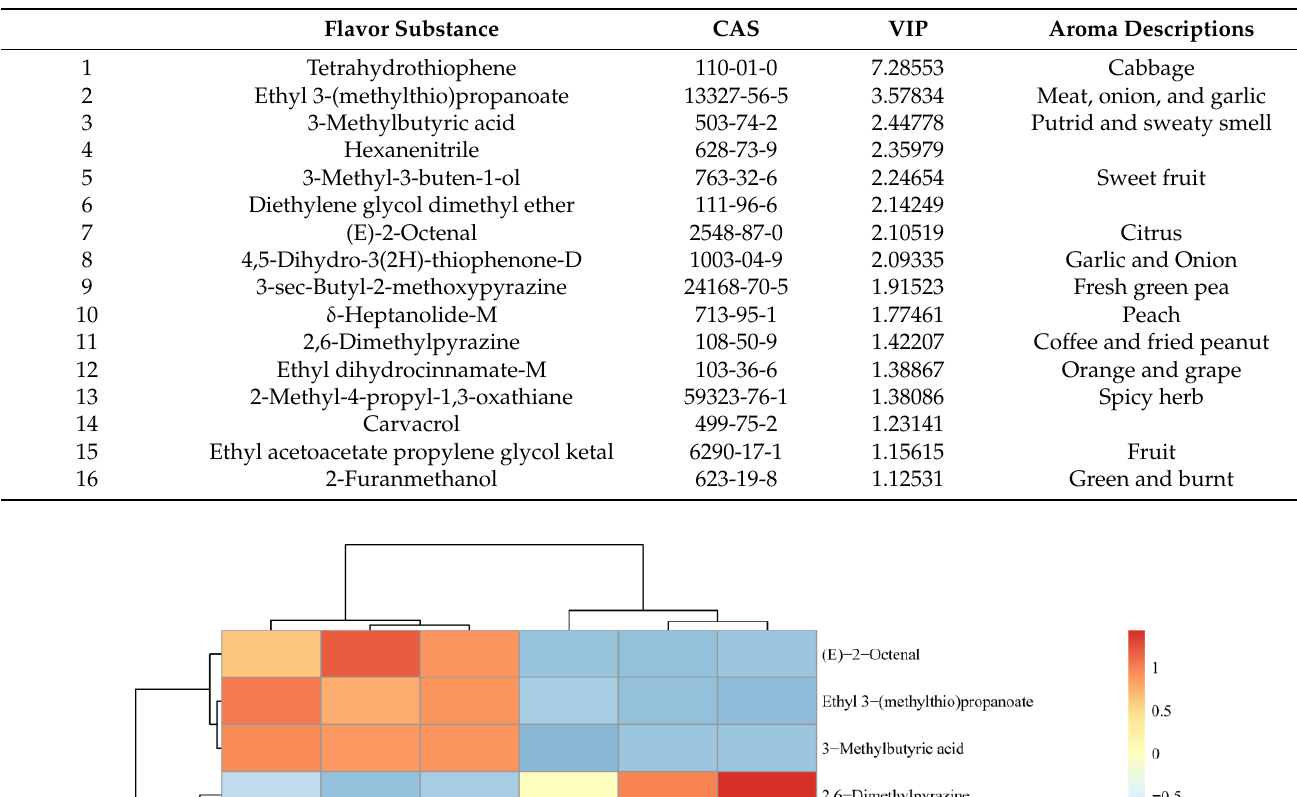
Table 4. The VIP values for differential volatile flavor substances between LSCK and HSCK.